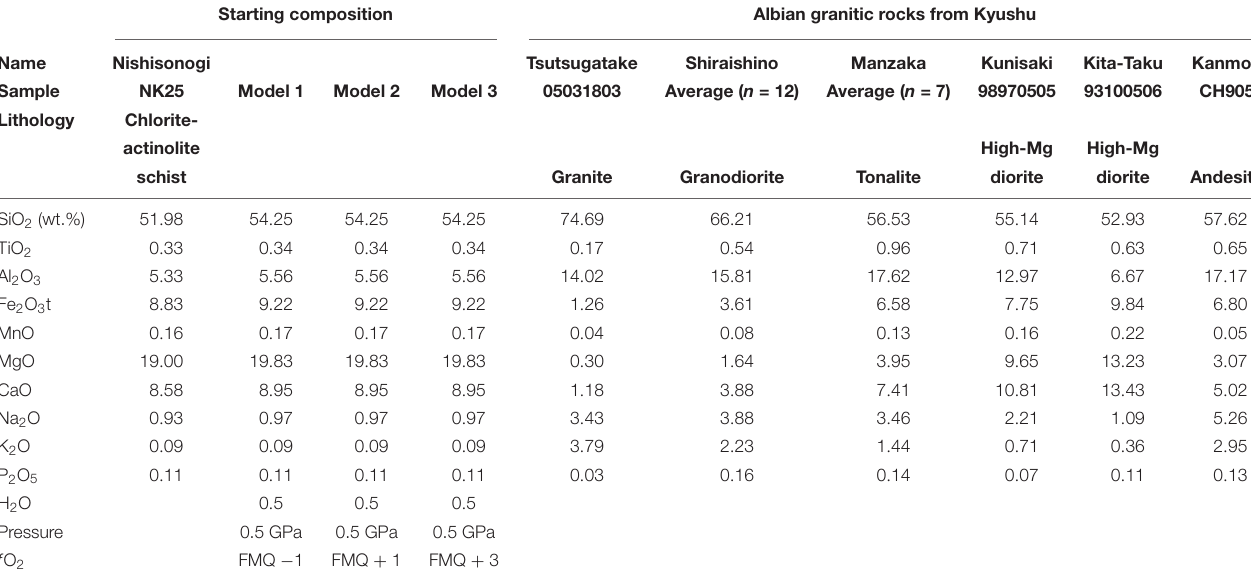
TABLE 1 | Starting compositions used for equilibrium partial melting models and compositions for Albian granitic rocks from Kyushu. Starting composition Albian granitic rocks from